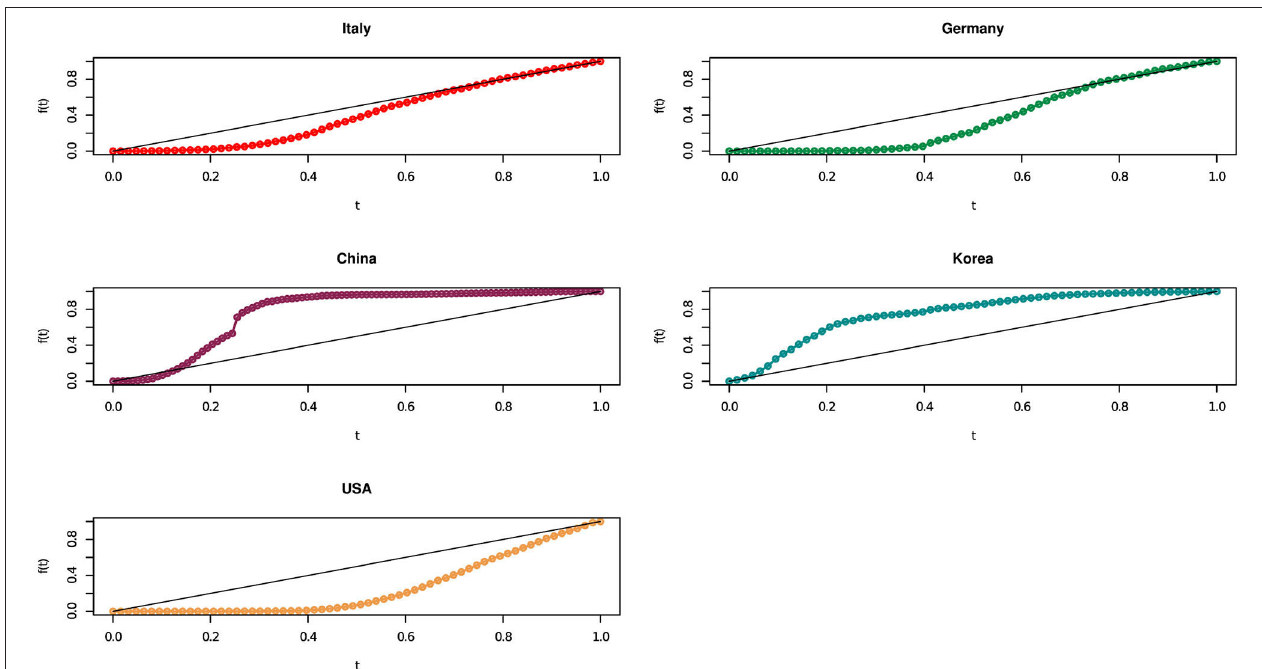
FIGURE 2 | The concordance curve behavior for Italy, Germany, China, Korea, and USA.